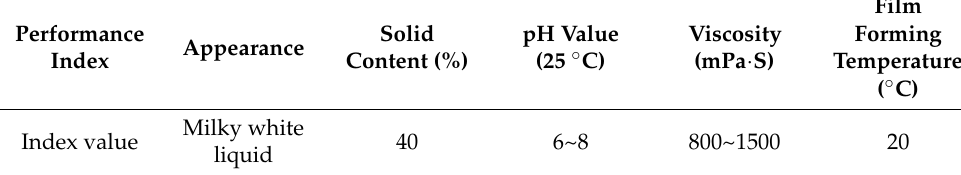
Table 2. Performance indexes of WPU solution.